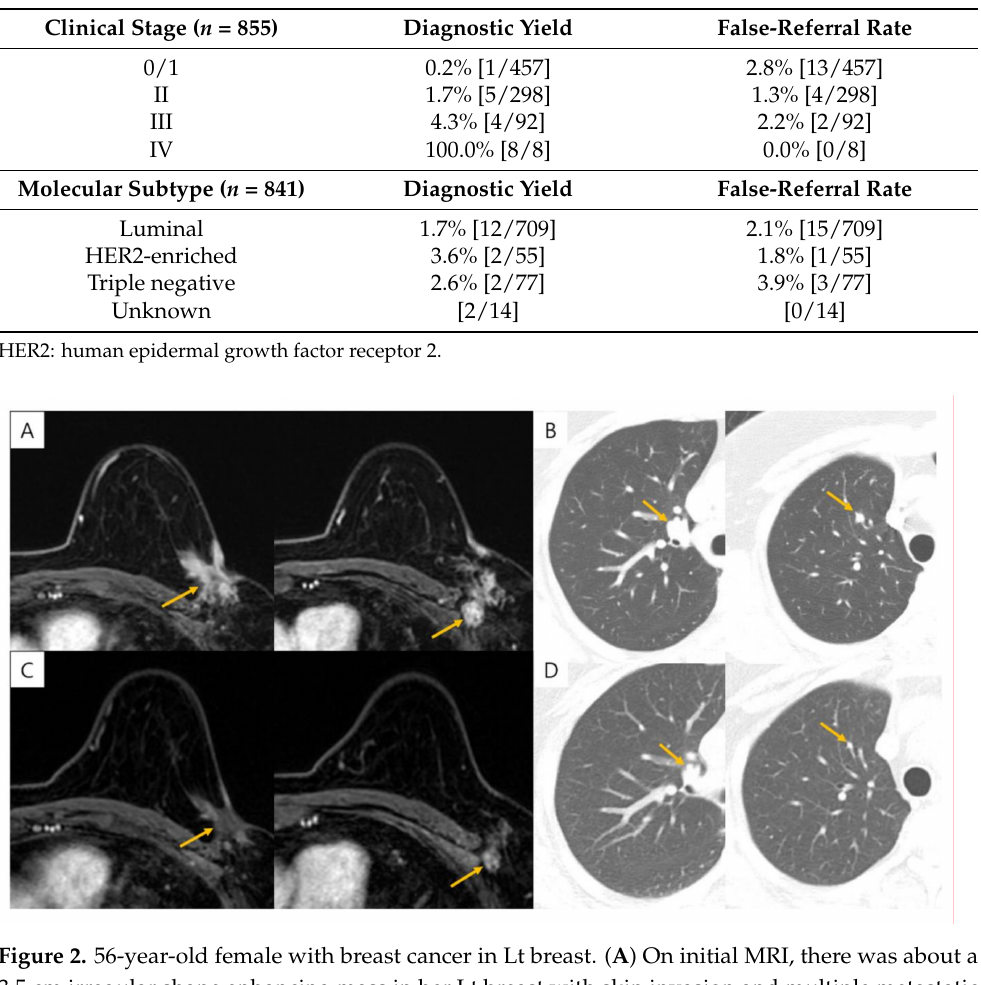
Table 4. Diagnostic yield and false-referral rate of chest CT for the detection of distant metastasis according to clinical stage and molecular subtype.